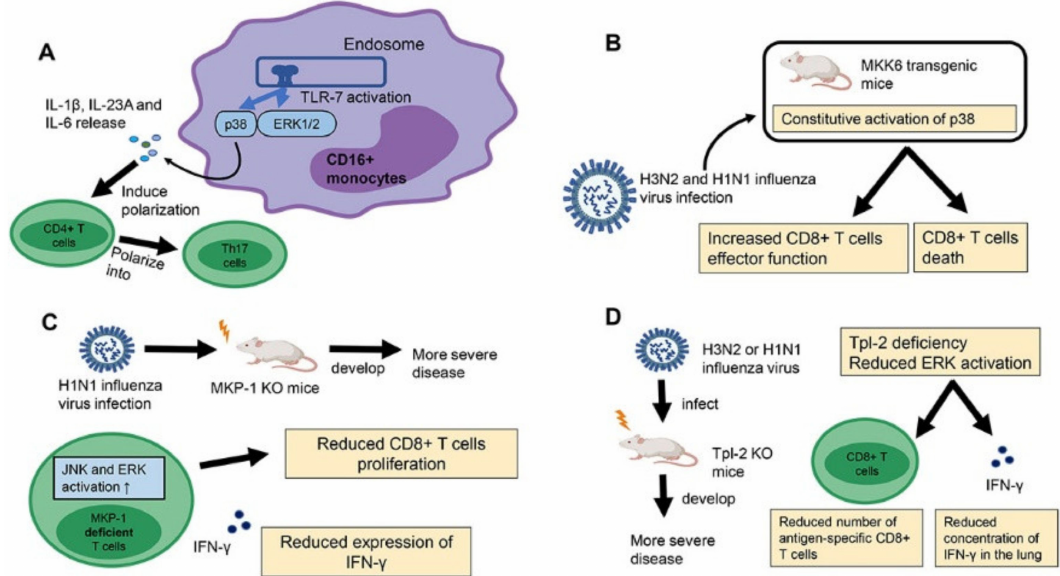
Figure 2. Regulatory function of MAPKs in influenza A virus (IAV)-specific T-cell responses. ( A ) Upon IAV infection, TLR7 signalling activates p38 and ERK1 / 2 in human CD16 + monocytes. Consequently, p38 and ERK1 / 2 activation induces expression of IL-1 β , IL-23A and IL-6, which selectively polarize CD4 + T-cells into T H 17 cells. ( B ) Constitutive p38 activation in MKK6 transgenic mice promotes CD8 + T apoptosis in response to H3N2 and H1N1 influenza virus infection, leading to reduced number of IAV-specific CD8 + T-cells. However, IAV-specific CD8 + T-cells enhanced e ff ector function and the ability of virus clearance. ( C ) Activation of JNK and ERK is increased in MKP-1 deficient T-cells, associated with reduced antigen-specific CD8 + T-cells in the lungs and reduced IFN- γ expression by T-cells. Consequently, MKP-1 KO mice developed a higher severity of disease in response to H1N1 influenza virus infection. ( D ) Tpl-2 is a MAPK kinase kinase which activates ERK through MEK1 / 2. Compared to WT mice, the Tpl-2 KO mice developed a higher severity of the disease upon H3N2 or H1N1 influenza virus infection due to reduced number of influenza-specific CD8 + T-cells and reduced IFN- γ expression in the